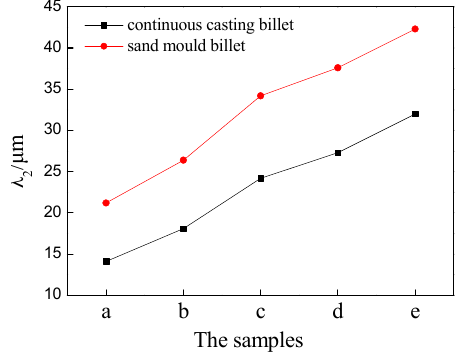
Figure 5. λ 2 of the different samples from the M2 steel billets.